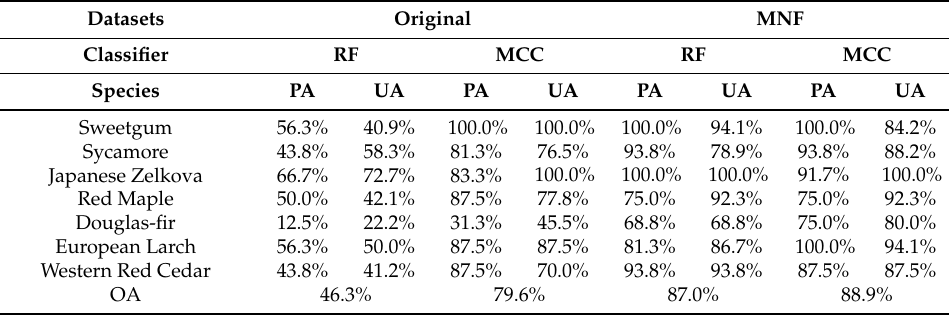
Table 2. Classification results in terms of PA (producer’s accuracy), UA (user’s accuracy) and OA (overall accuracy) for seven tree species. Accuracies were obtained using different combinations of datasets and classifiers of the 10-fold cross-validation